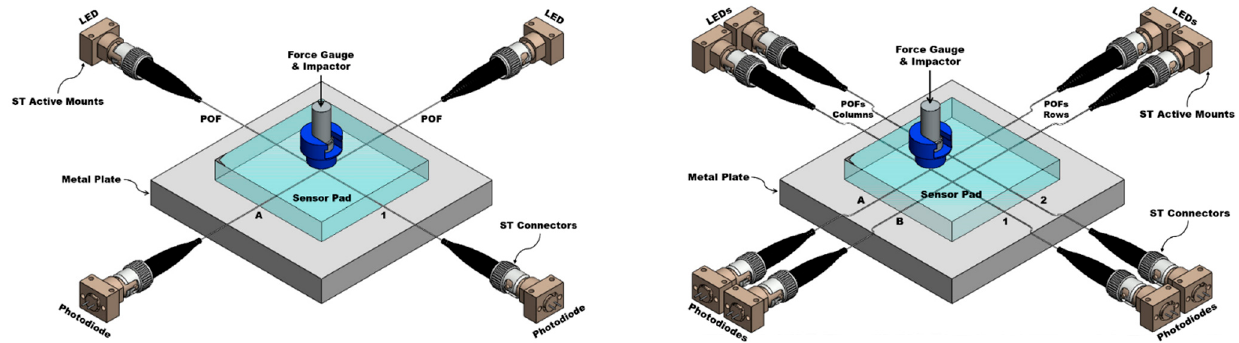
Figure 6. Three ‐ dimensional representation of the experimental setups used to expose the 1 POF × 1 POF ( left ) and 2 POFs × 2 POFs ( right ) samples to the pressures selected with the LEDs and photodiodes coupled to each fiber.